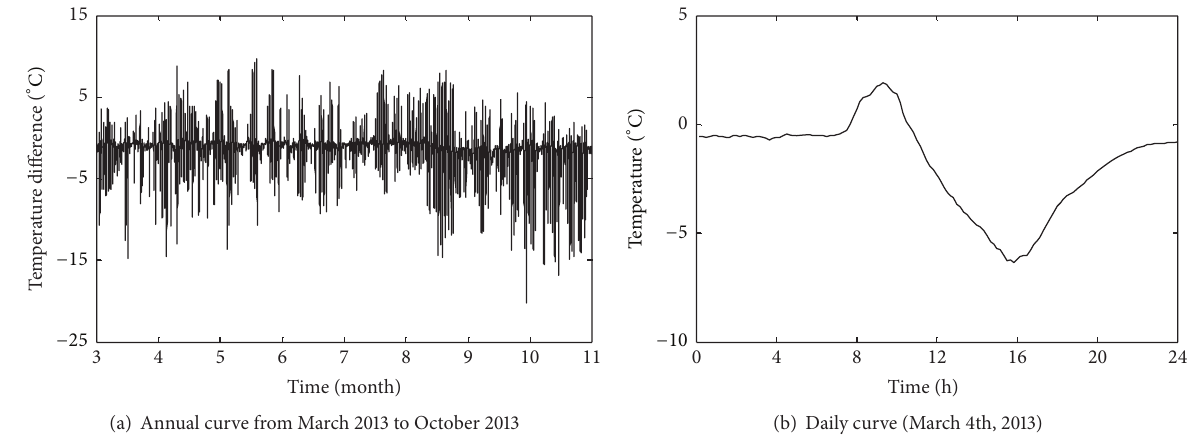
Figure 13: Time-history curves of temperature difference data 𝑇 12 .